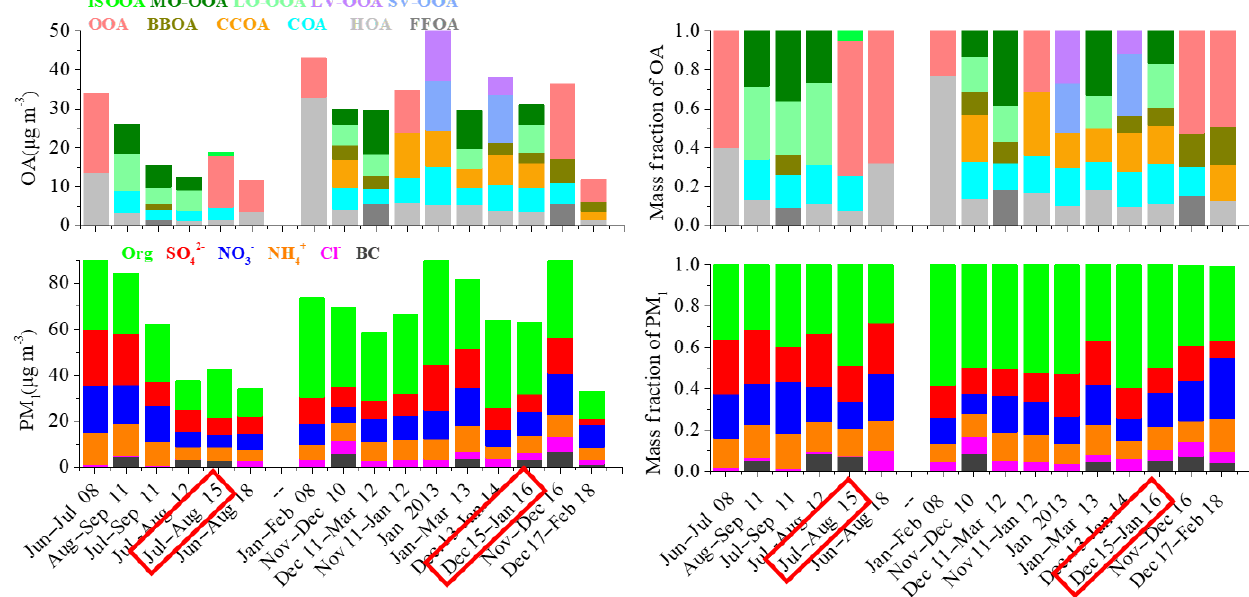
Figure 2. Summary of average chemical composition of OA and PM 1 in urban Beijing between summer and winter from 2008 to 2018. A more detailed description of the data is presented in Table S1 in the Supplement. As for OA sources, fossil-fuel-related OA (FFOA) is the sum of HOA + CCOA, SV-OOA is semi-volatile OOA and LV-OOA is low-volatility OOA. The date highlighted in red indicate measurements taken during this study in